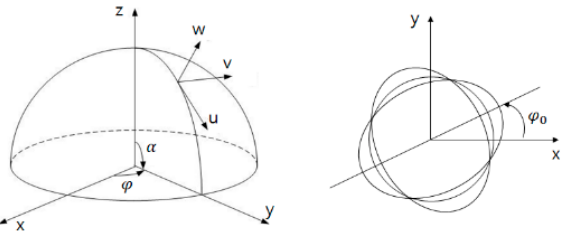
Figure 6. The position of a point on the shell with the angular coordinates α,φ in a Cartesian coordinate frame fixed to the resonator.